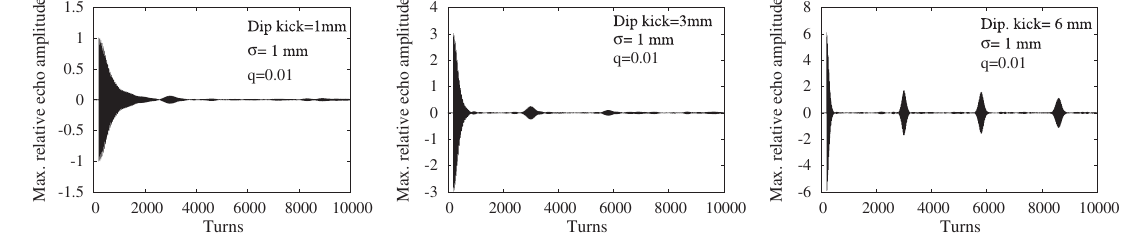
FIG. 9. Multiple echoes at constant emittance, quadrupole kick, and increasing values of the dipole kick strength, left to right. The second echo (centered at turn 5800) and third echo (centered at turn 8600) become visible at the larger dipole